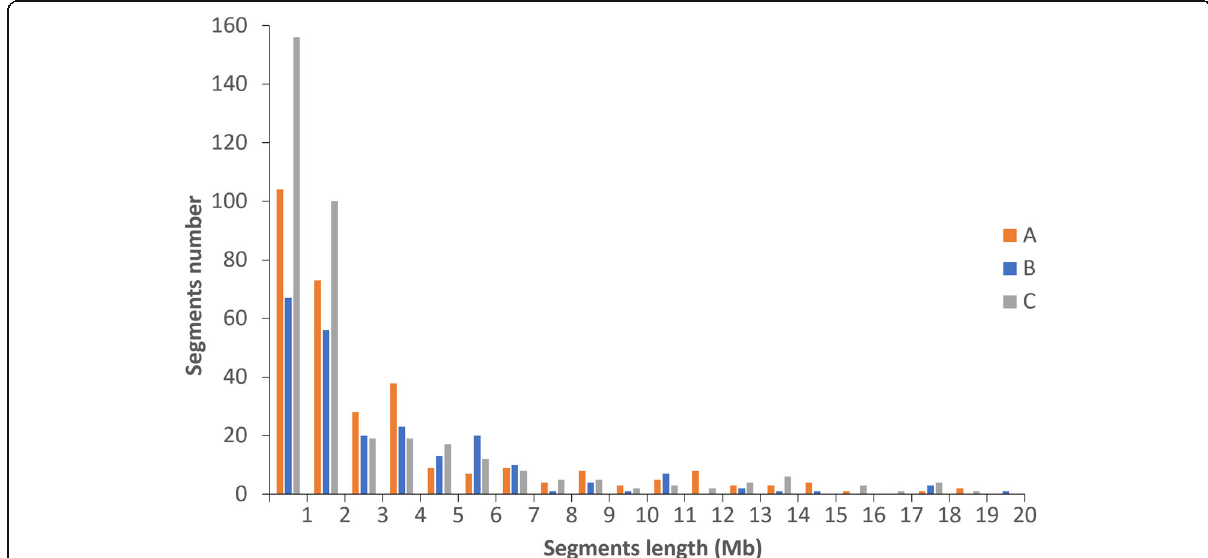
Fig. 3 Distribution of the lengths of the substituted segments in the 3 sets of CSSLs. A, B and C represent A set CSSLs, B set CSSLs and C set CSSLs,